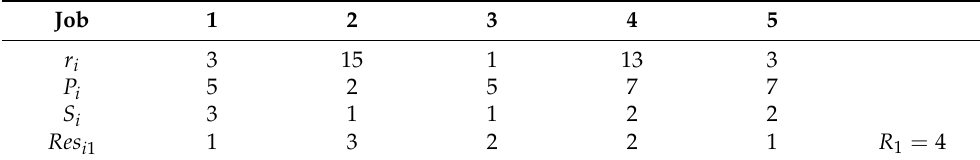
Table 3. The relaxed input